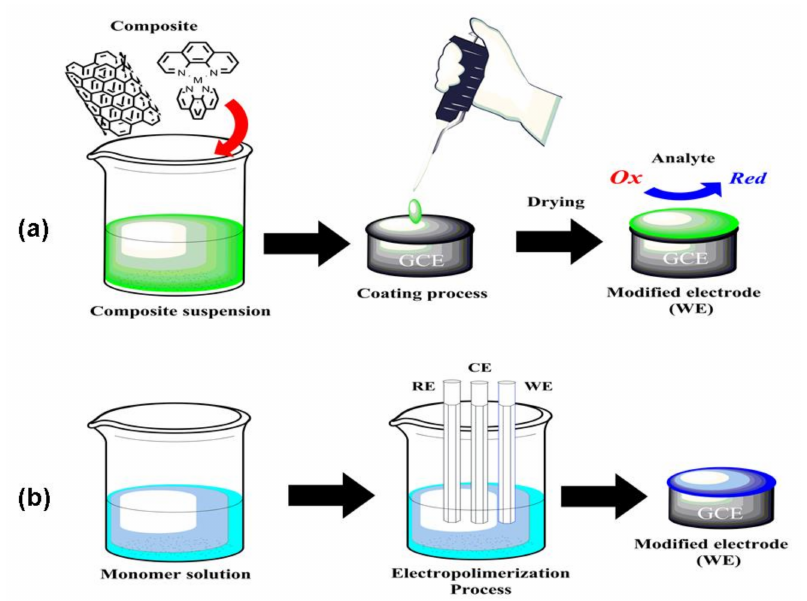
Figure 2. ( a ) GCE coating modification process; ( b ) GCE electropolymerization coating